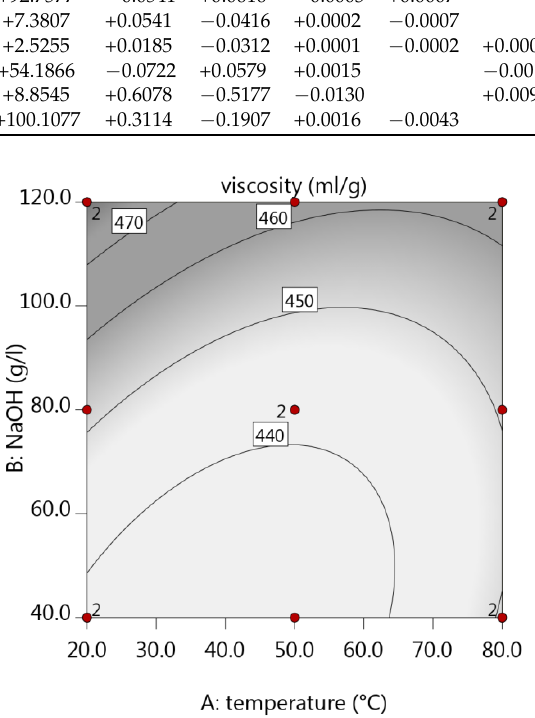
Figure A1. Response surface of pulp viscosity in correlation with temperature and NaOH concentration.